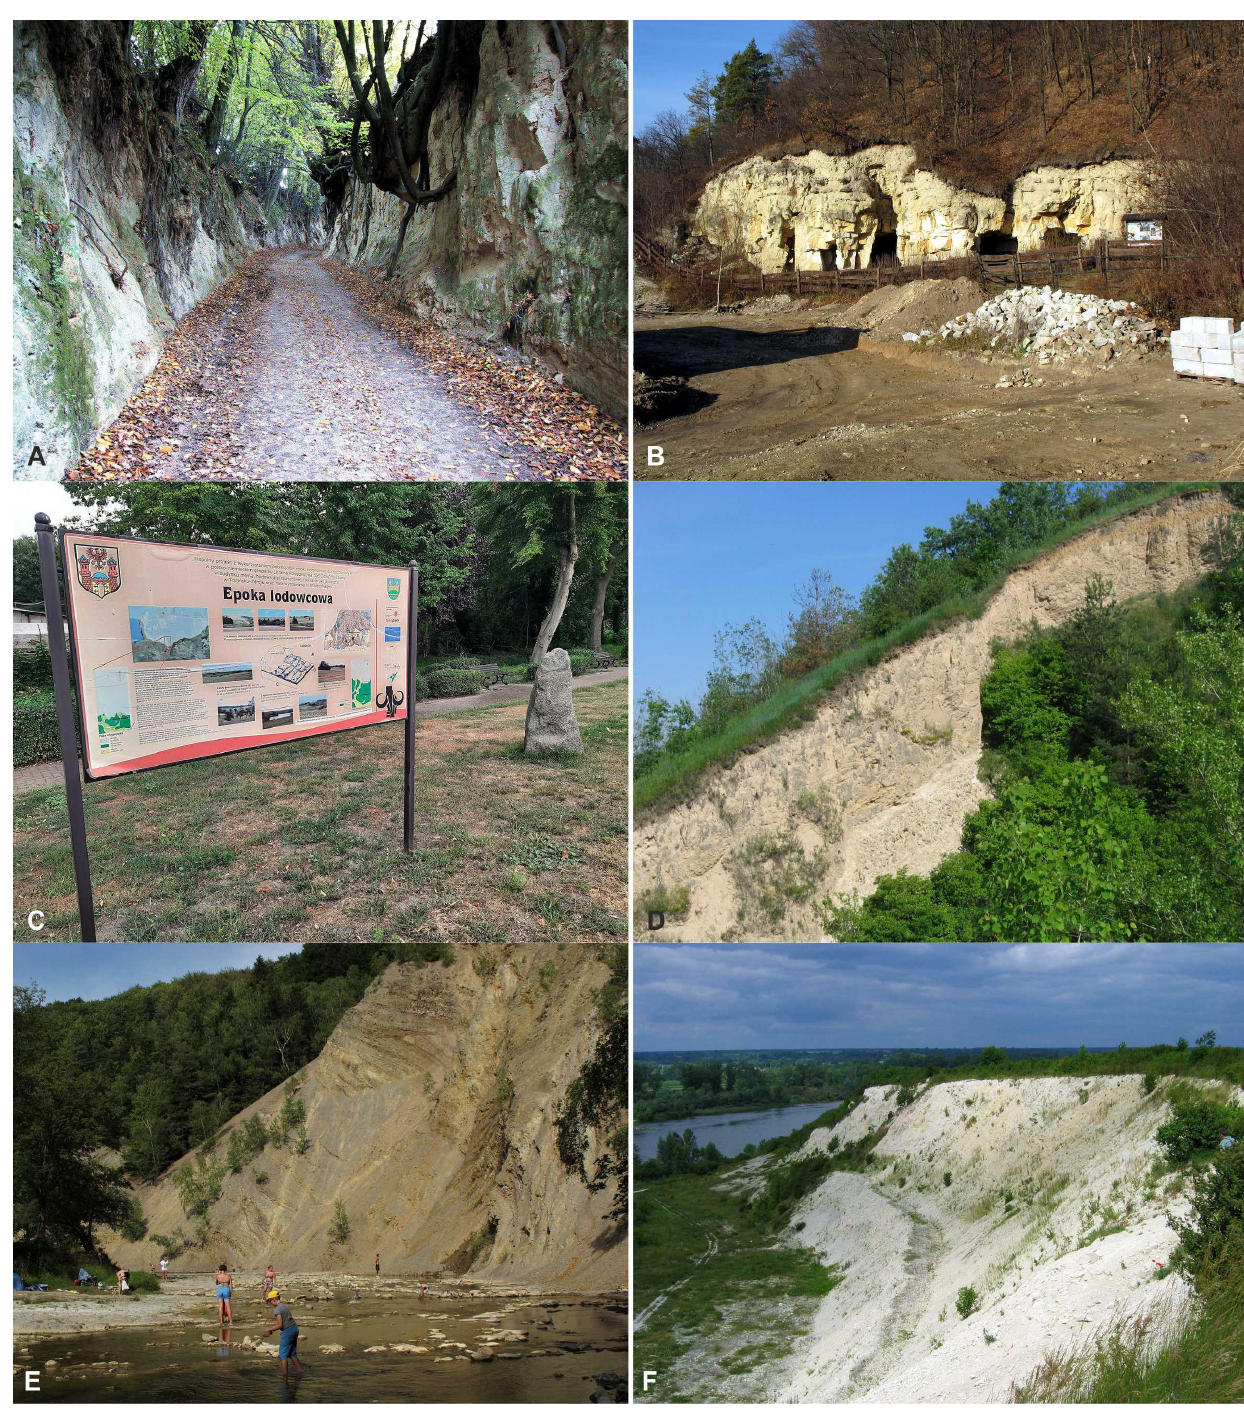
Figure 2. Examples of geoheritage of landscape parks and planned geoparks in Poland. ( A